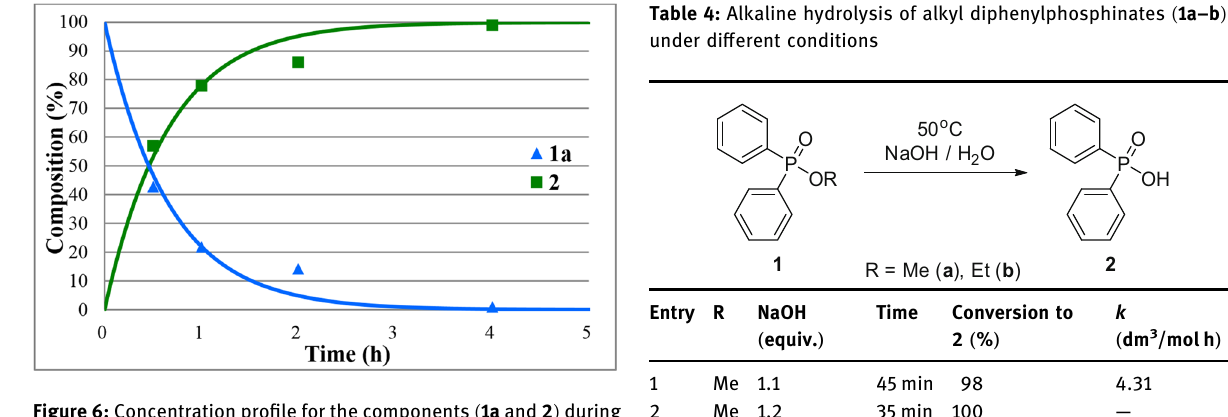
Figure 6: Concentration pro fi le for the components ( 1a and 2 ) during the hydrolysis of methyl diphenylphosphinate ( 1a ) under MW conditions at 160°C. The R 2 measure of goodness of fi t is 0.977.